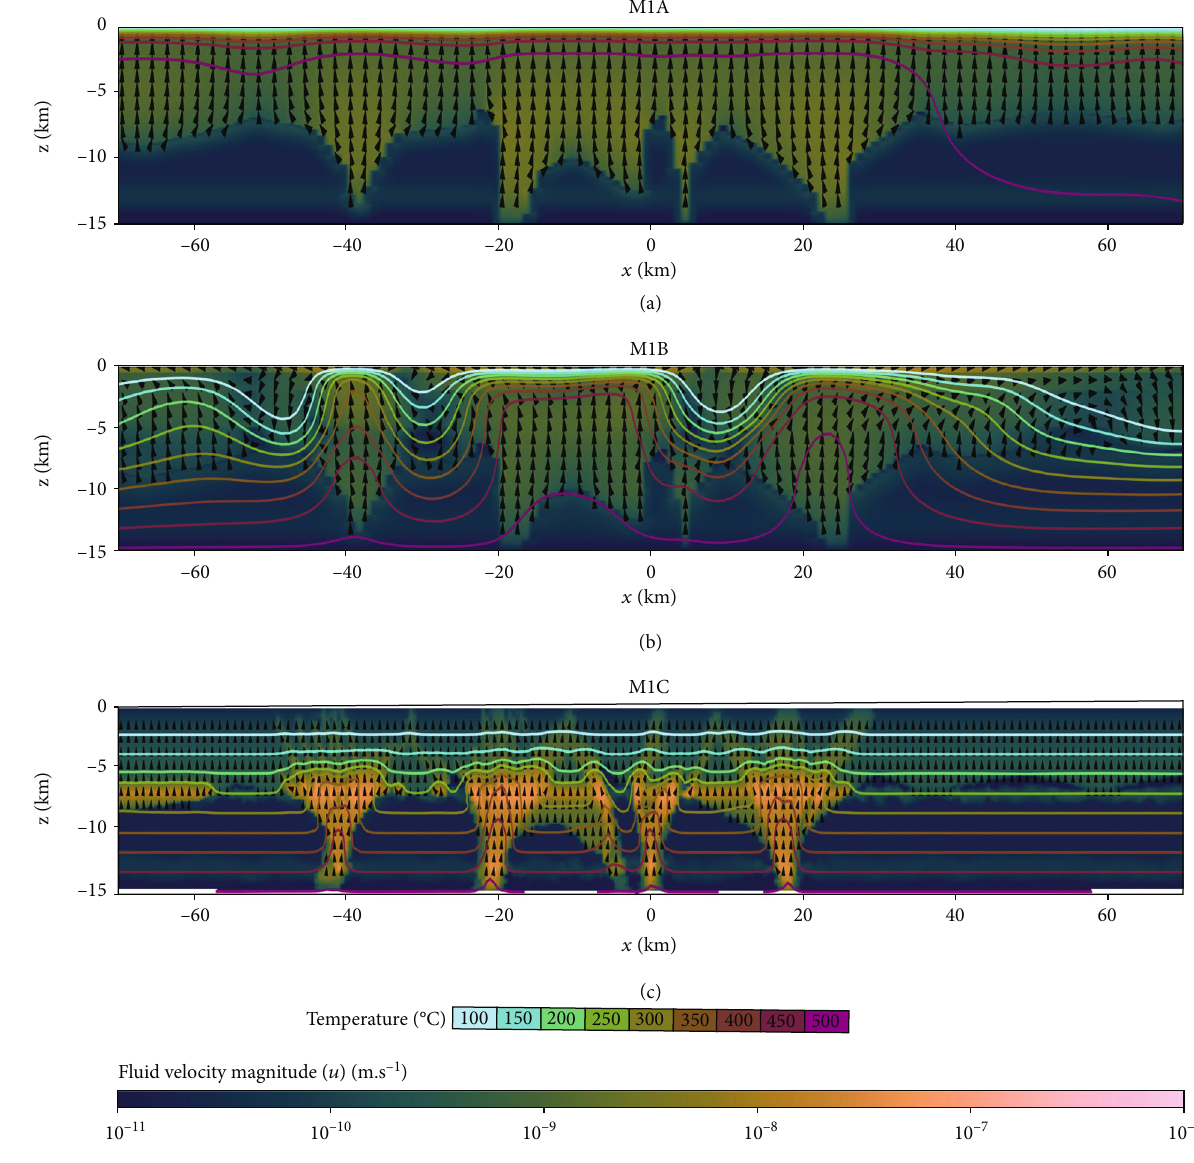
Figure 6: Thermal and fl uid fl ow results for models (a) M1A, (b) M1B, and (c) M1C. Permeability setups for each model can be referred to Figure 3. Isotherms are represented by solid-coloured lines in increments of 50 ° C. Colour fi ll of the plots and isotherms is based on scienti fi c colour maps